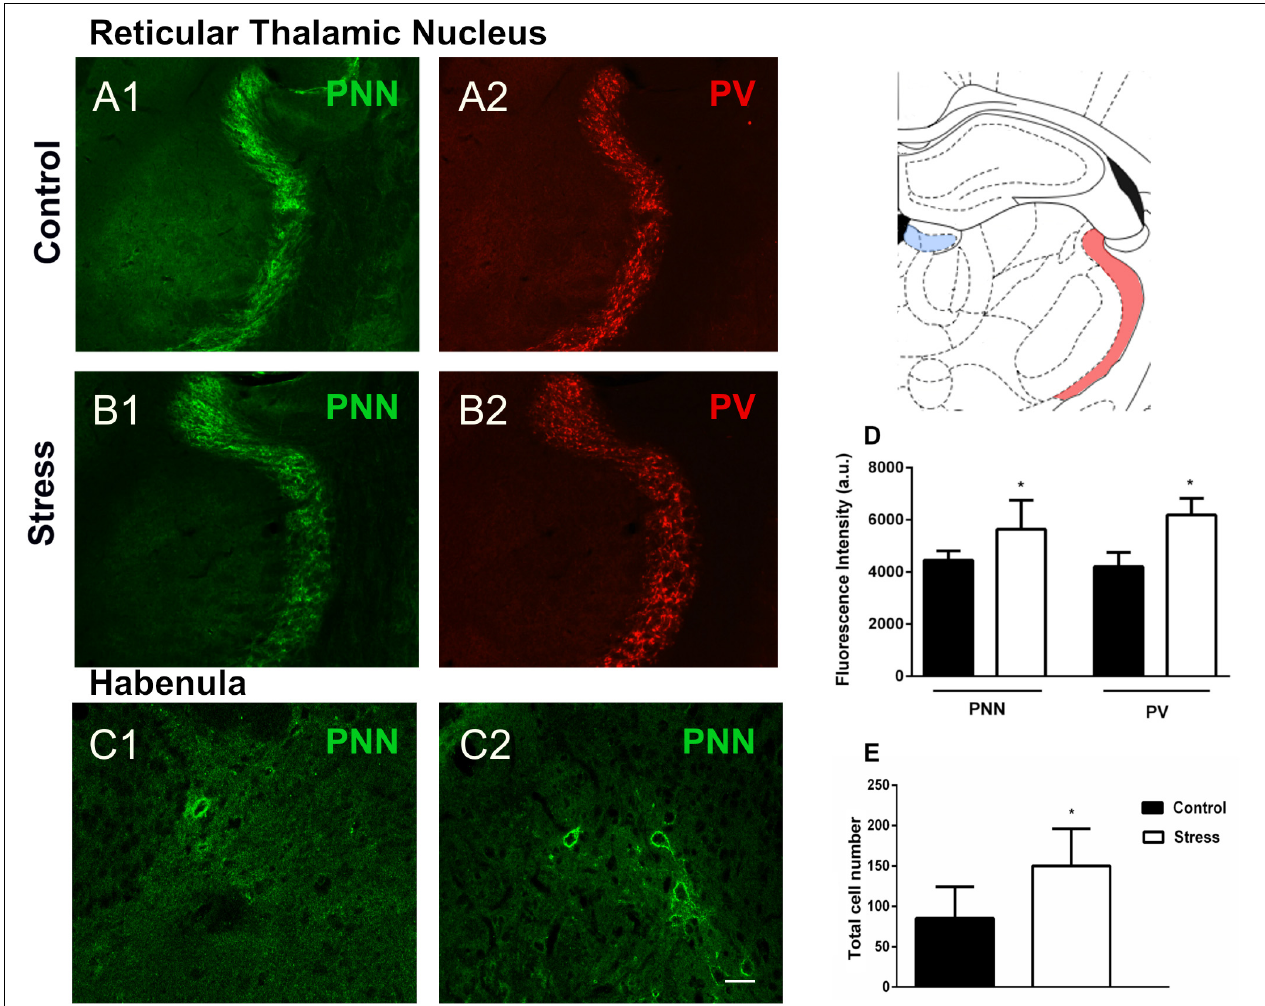
FIGURE 3 | Perineuronal nets (PNN), parvalbumin (PV) expressing neurons and their colocalization in the reticular thalamic nucleus and the habenula in control rats and after 10 days of chronic restraint stress. (A,B) Representative confocal images showing the distribution of PNN ( A1,B1 ; green) and PV + somata ( A2,B2 ; red) in the reticular thalamic nucleus of control (A) and stressed (B) rats. (C) Confocal images showing the distribution of PNN (green) in the habenula of control (C1) and stressed (C2) rats; no PV immunoreactive somata could be detected in the habenula, neither in control nor in stressed animals. (D,E) : Graphs on the right side of the figure indicate changes in the fluorescence intensity of PNN and PV stainings in the reticular thalamic nucleus (D) and of the total numbers of PNN in the habenula (E) . Schemes on the top right of the figure indicate the studied regions in light red (reticular thalamic nucleus) and light blue (habenula) (modified from Paxinos and Watson, 1998). Values represent mean ± S.E.M. Asterisks indicate statistically significant differences between groups (Control × Stress) after unpaired Student’s t -test ( ∗ p < 0.05). Scale bar 15 µ m.